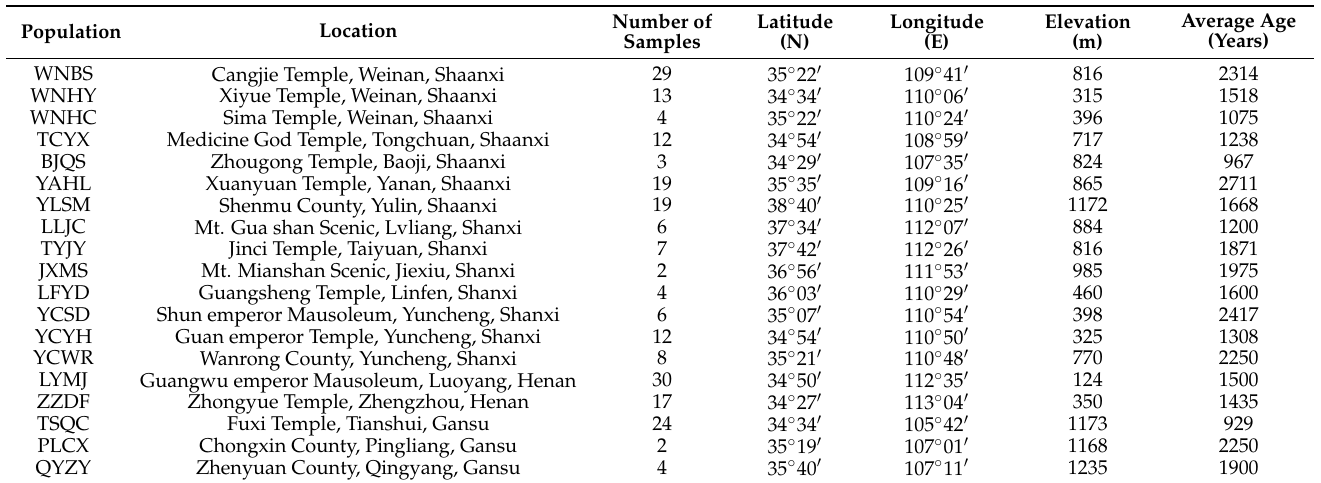
Table 1. Sampling Locations for the 19 ancient P. orientalis populations.